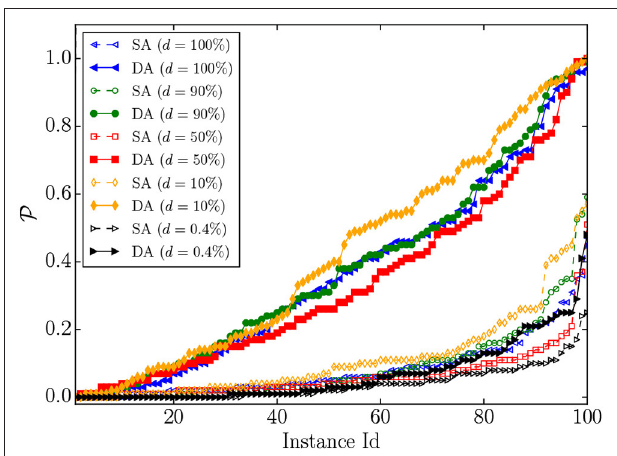
FIGURE 11 | Success probabilities ( P ) of 100 spin-glass problem instances with different densities solved by the SA and the DA algorithms. The number of Monte Carlo sweeps in SA is 10 4 and the number of iterations in the DA is 10 7 , corresponding to ≃ 10 4 Monte Carlo